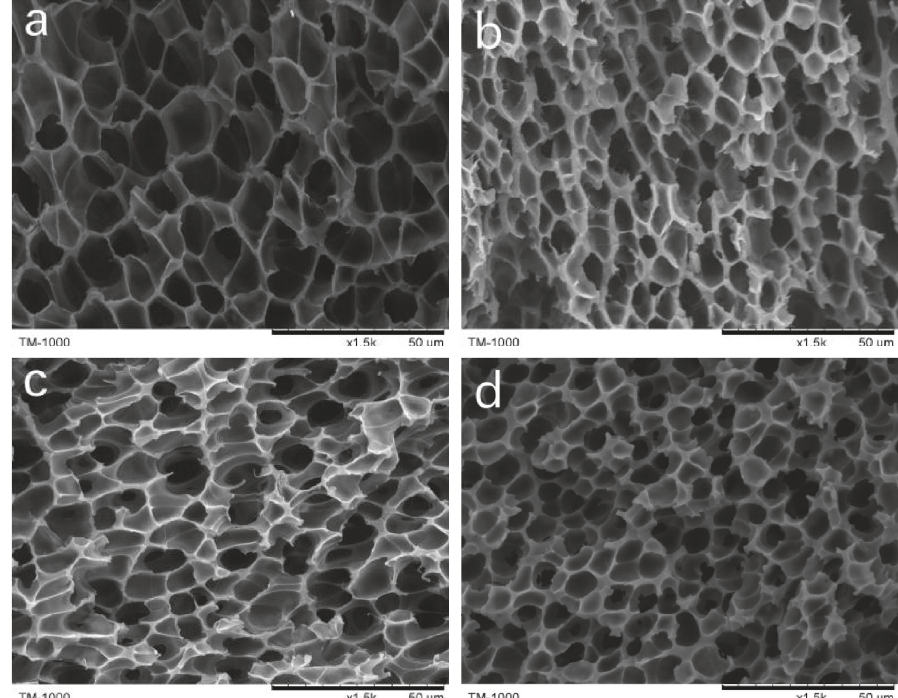
Figure 12: Comparative analysis of PLA foaming nanocomposite cell structures (110 ° C, 18MPa, 2 h): (a) PLA/NCC-2, (b) PLA/NCC-6, (c) PLA/mNCC-2, and (d) PLA/mNCC-6.